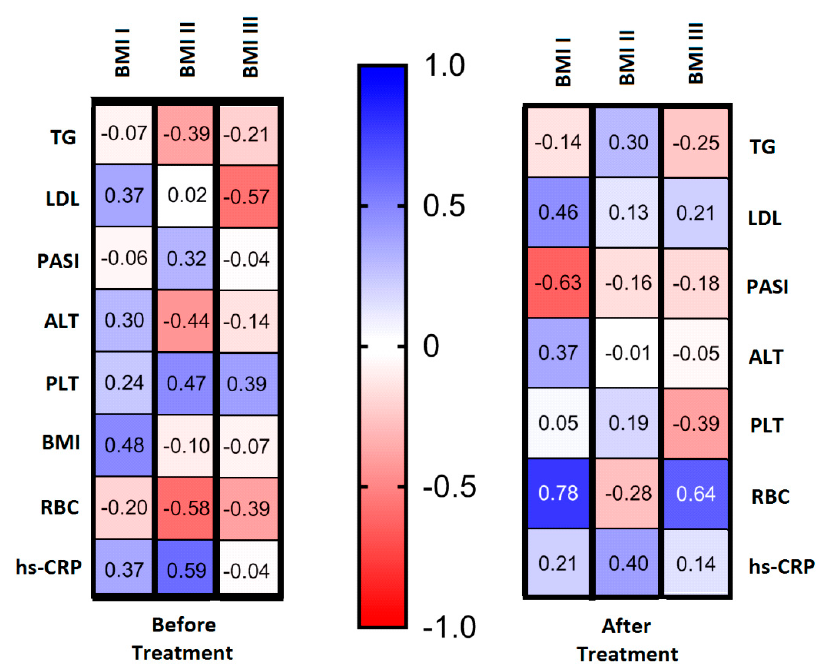
Figure 4. Chosen correlations inside BMI subgroups: before and after total treatment with use of Spearman’s rank correlation.